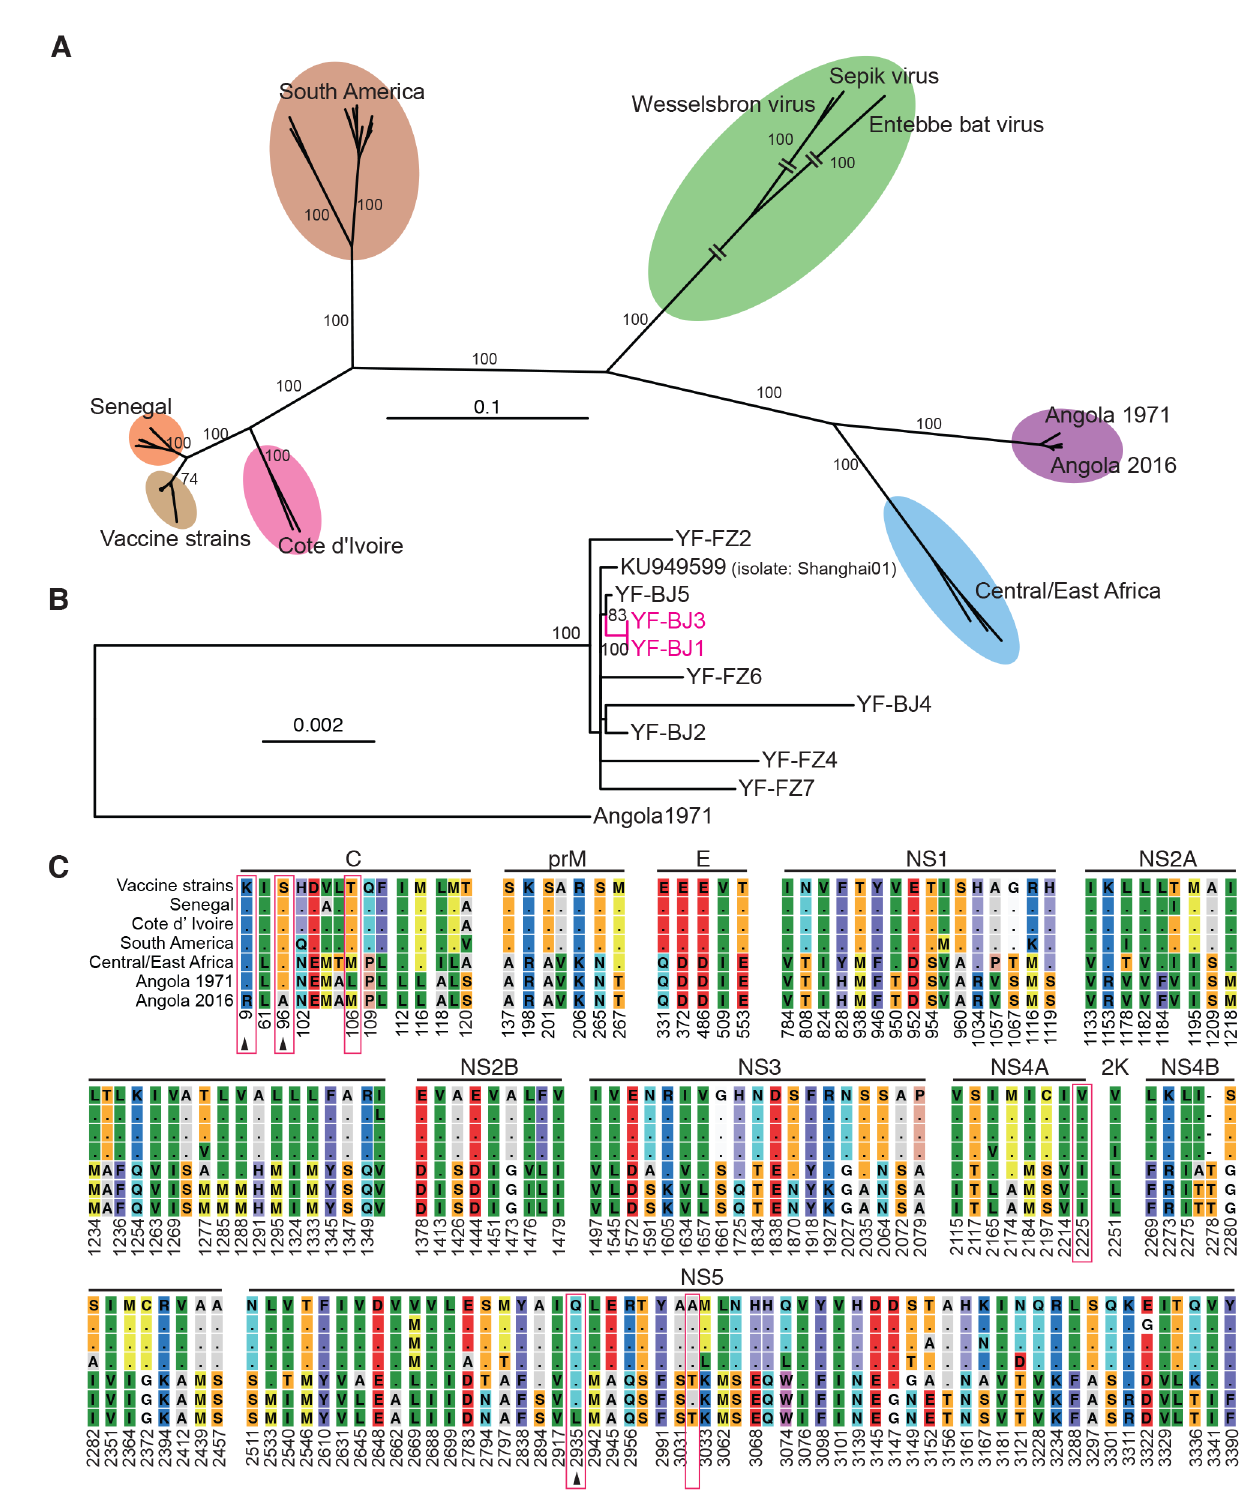
Fig 2. Phylogenetics and amino acids comparison of YFV viruses. (A) Maximum-likelihood phylogenetic tree of YFV genome sequences (the first 130 bps in 5’-UTR and the last 370 bps in 3’-UTR sequences are excluded). Bootstrap support values are shown along the branches. Wesselsbron virus, Sepik virus and Entebbe bat virus were used as outgroup. (B) Maximum-likelihood phylogenic tree of YFV genomes of Angola 2016 strains. Viruses from patients with severe